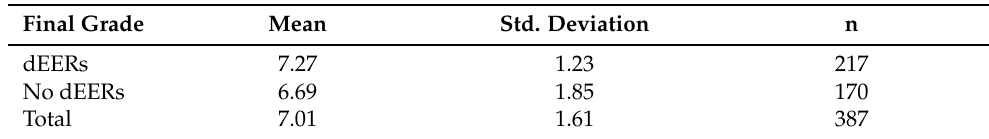
Table 4. Final grades vs. participation in